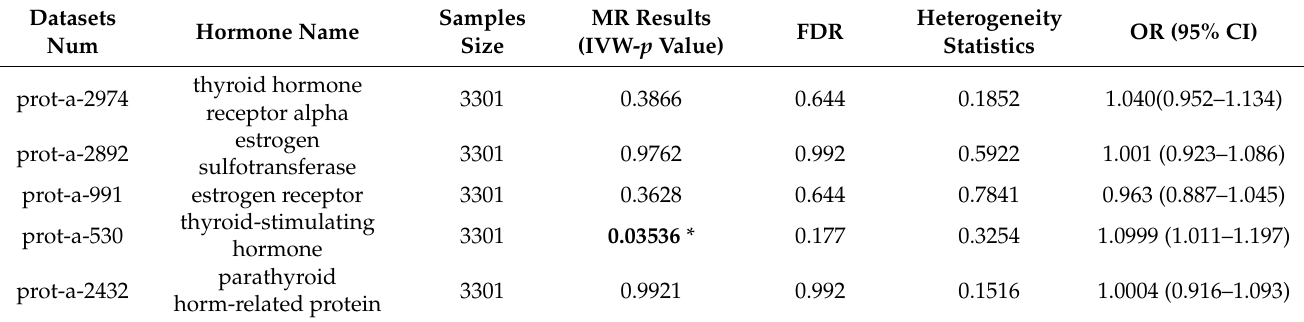
Table 3. The 2SMR results of SCZ and hormones using IVW